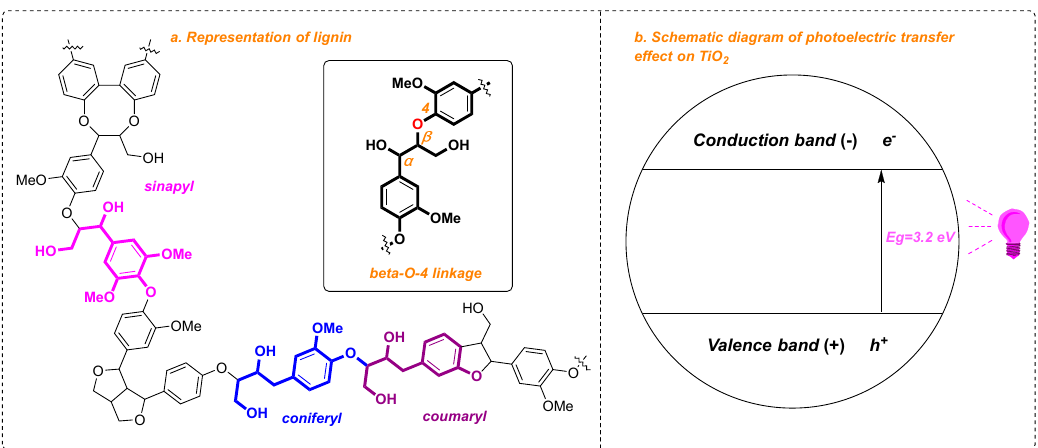
Figure 1. ( a ). Representative structure of lignin and beta- O -4 linkage in lignin, ( b ). Schematic diagram of photoelectric transfer effect on TiO 2 .